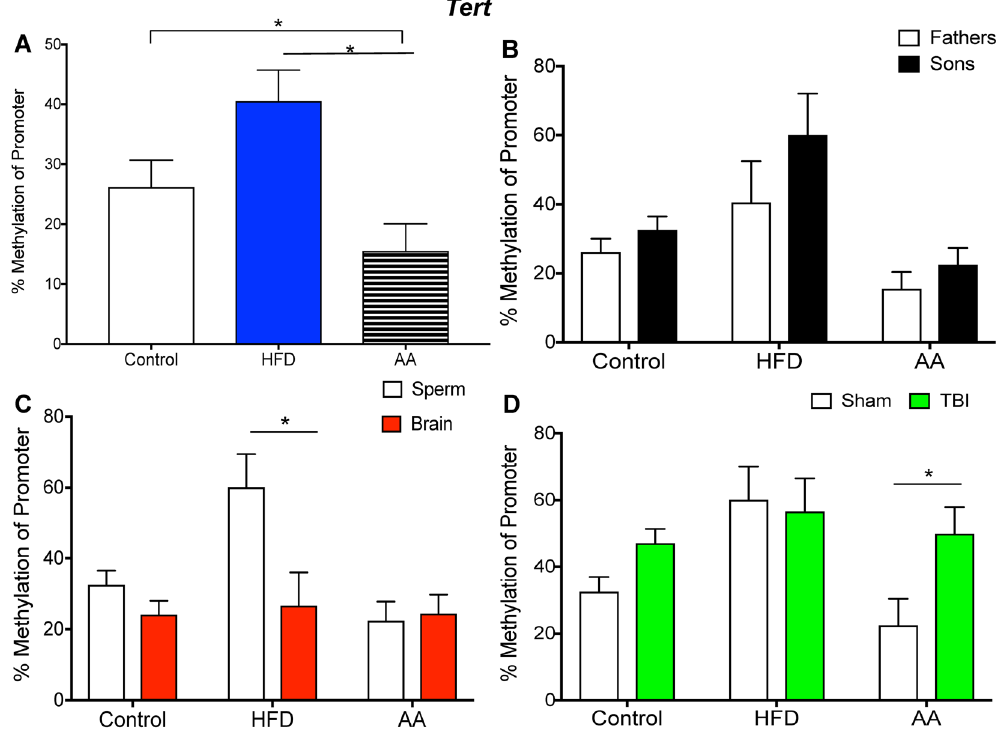
Figure 4. Illustrative demonstrations of Tert promoter methylation. One way ANOVAs were conducted and significant main effects are indicated ( * p < 0.05). ( A ) Average Tert promoter methylation in paternal spermwas significantly increased in HFD sperm compared to AA and control sperm ( p < 0.05). ( B ) There were no significant differences in Tert promoter methylation between father and son sperm in all three paternal treatment conditions ( p > 0.05). ( C ) Tert promoter methylation in the sperm was significantly higher than brain methylation in HFD offspring ( p < 0.05). ( D ) The mTBI in AA offspring was associated with an increased Tert methylation ( p <